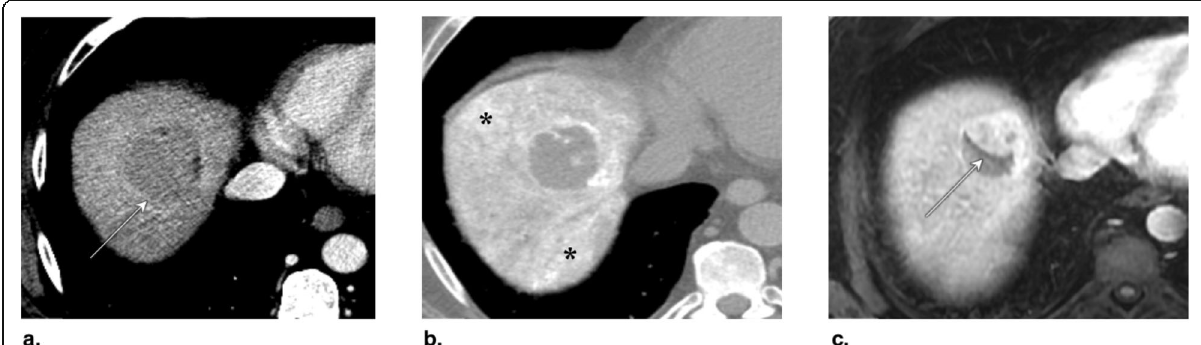
Fig. 23 a Axial CT in portal venous phase obtained pretreatment: image shows washout of a 4.8-cm LR-5 observation in segment VIII (arrow). b Immediately post transarterial chemoembolization (TACE) of right hepatic artery: unenhanced image shows diffuse ethiodized oil retention of the right lobe (asterisks). c Axial T1-weighted MR in late AP obtained 4 months post TACE: image shows a 3-cm hyperenhancing nodule at the anterior aspect of the treated lesion. The treated observation is categorized LR-TR Viable